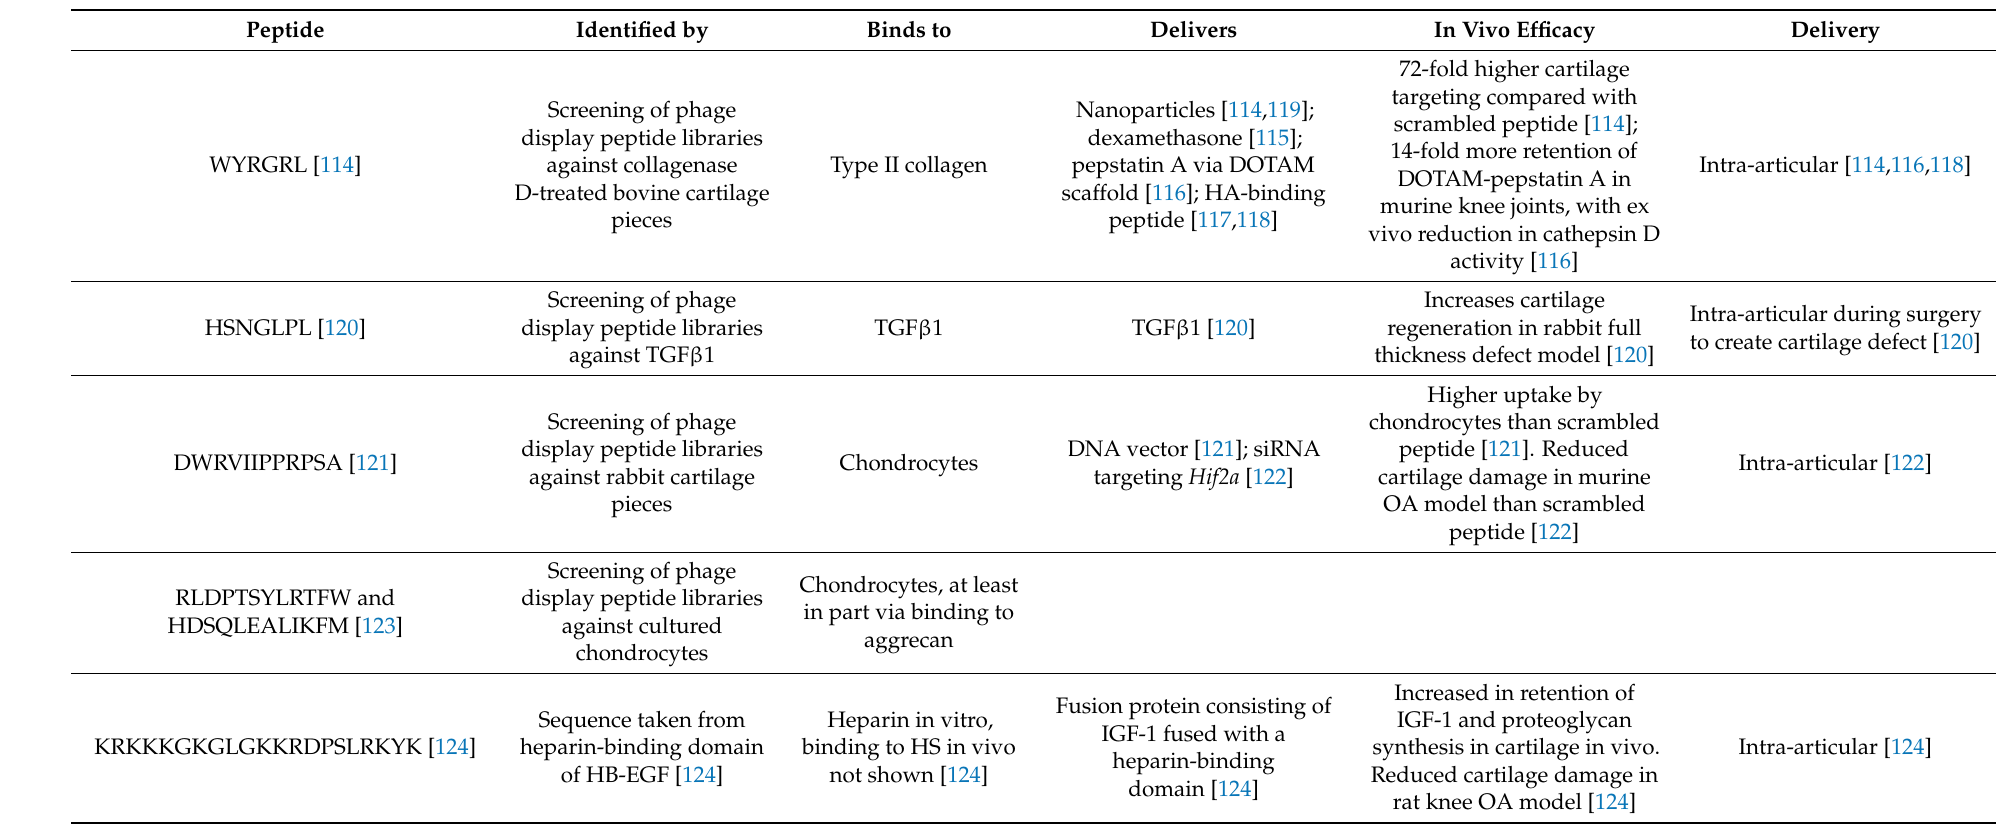
Table 1. Peptides tested for targeting of potential osteoarthritis (OA) therapies to